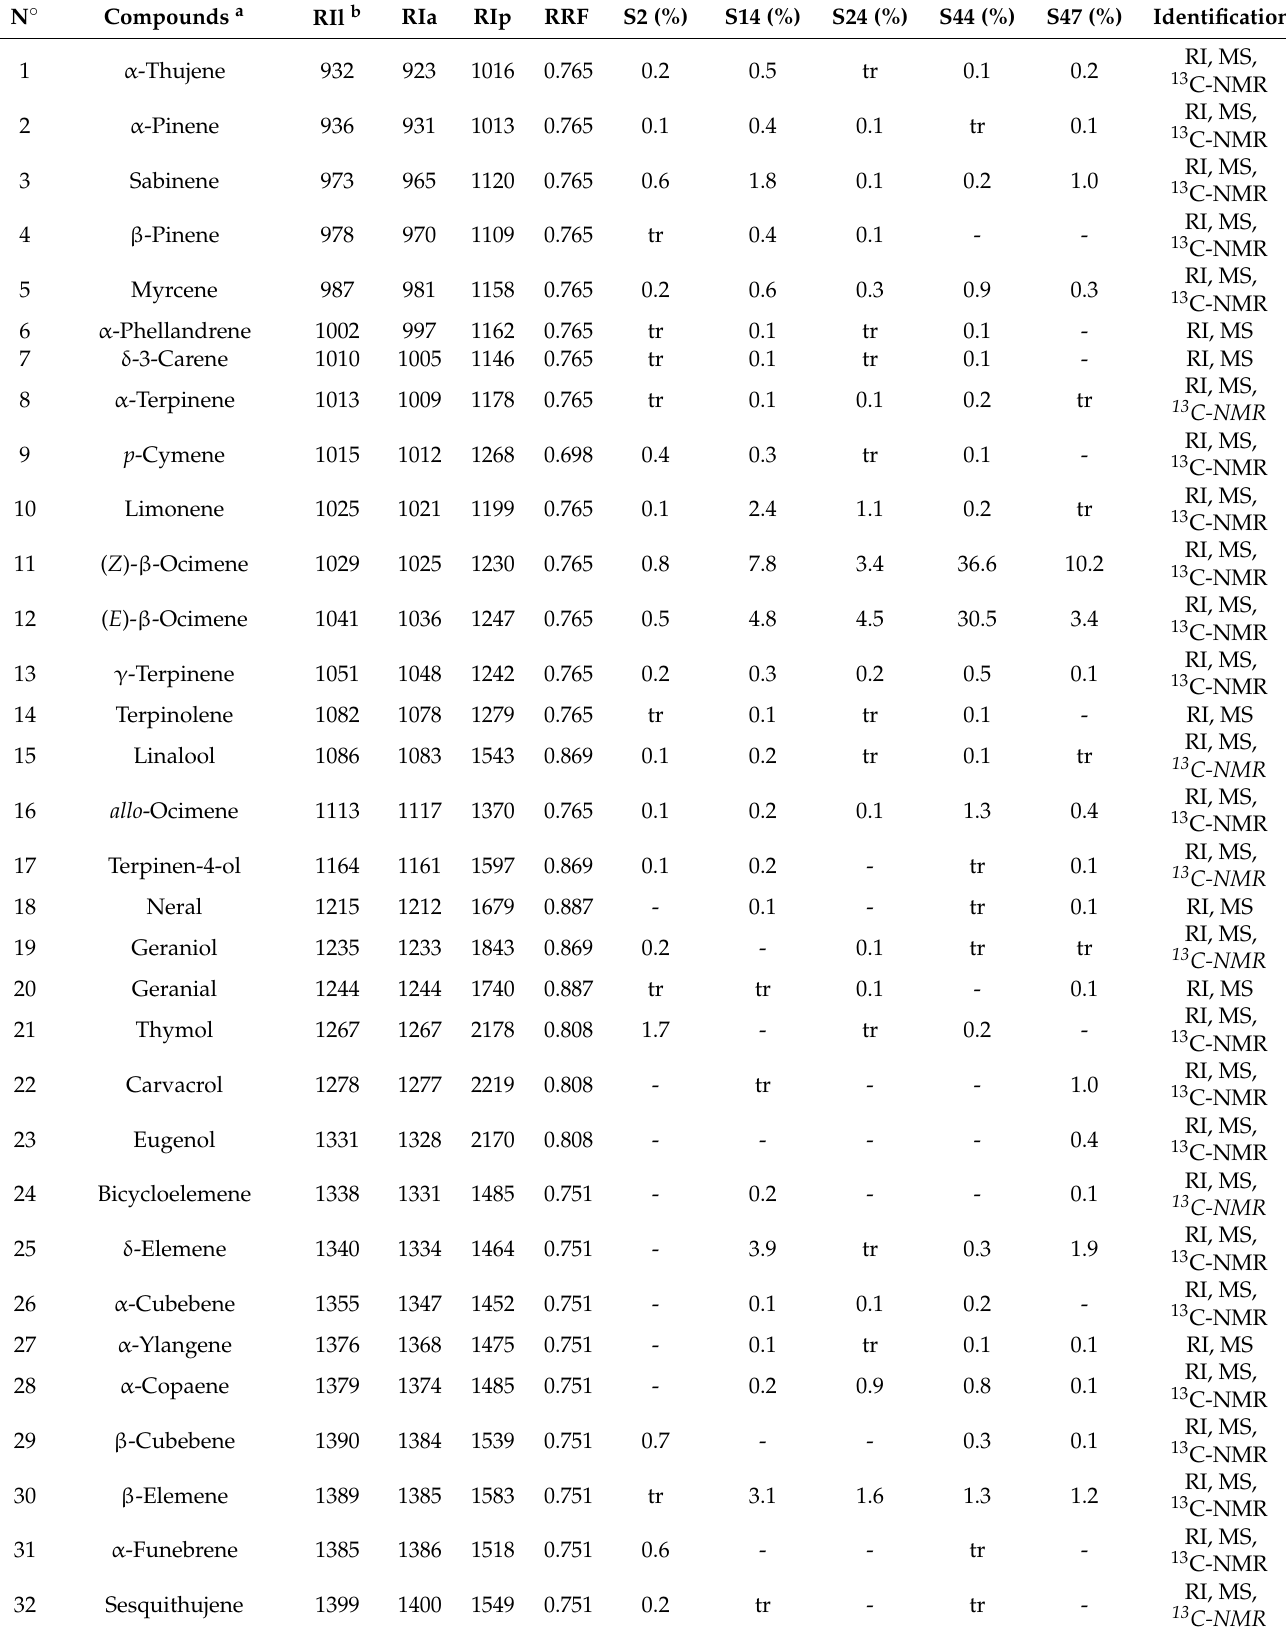
Table 1. Chemical composition of five leaf essential oil samples from Isolona dewevrei